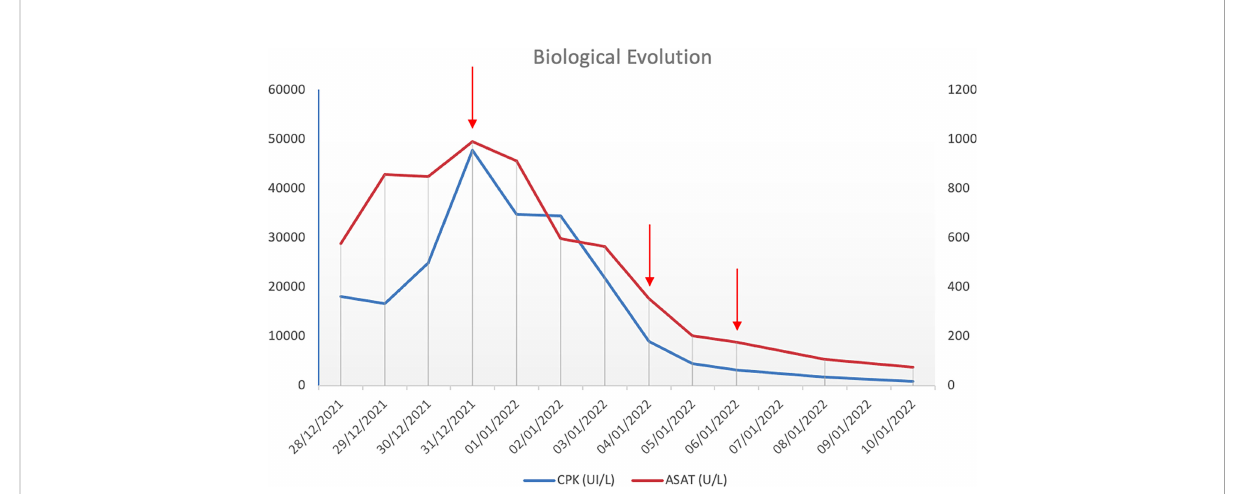
FIGURE 1 Evolution of CPK and ASAT after three plasma exchange cycles (red arrows). The natural evolution of CPK and ASAT levels before initiation of plasmatic exchanges is symbolized by red arrows. As illustrated, three plasmatic exchanges led to a signi fi cant decrease in both CPK and ASAT